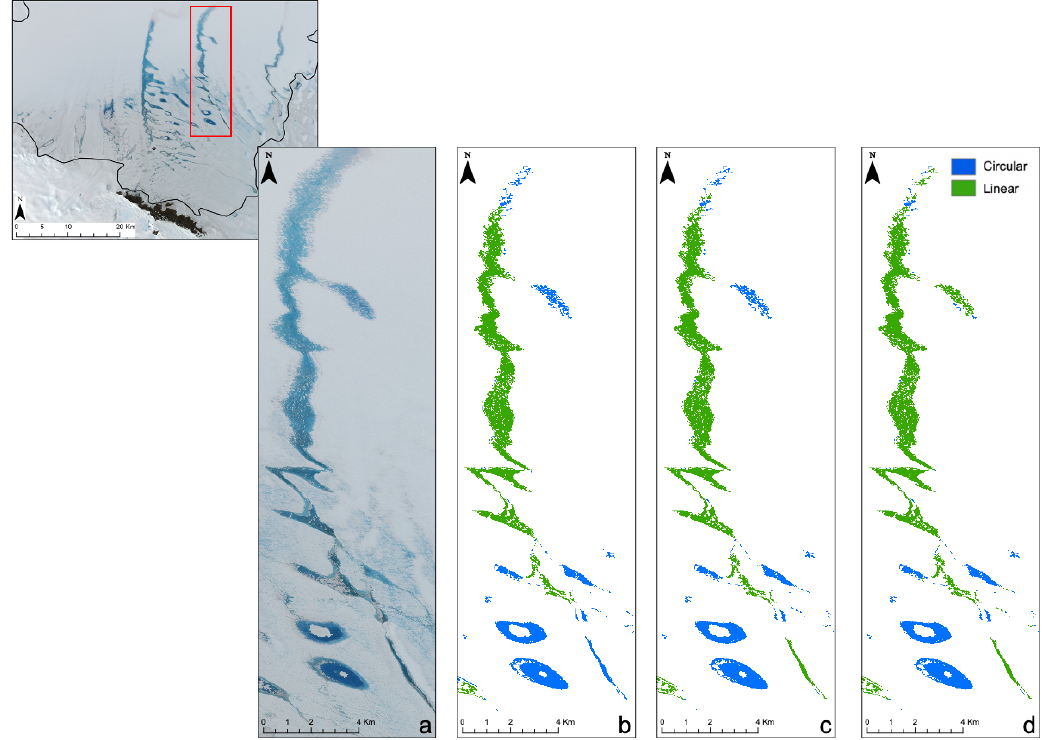
Figure 3. Solidity thresholds applied to water bodies identified on the Nivlisen Ice Shelf. The subset Sentinel-2 image is from 26 Jan- uary 2017, and the red box indicates the area shown in panels (a) – (d) . Panel (a) shows this area as an RGB, and panel (b) shows the water bodies identified and separated into linear or circular water bodies using a threshold of 0.42, (c) a threshold of 0.45, and (d) a threshold of 0.49.